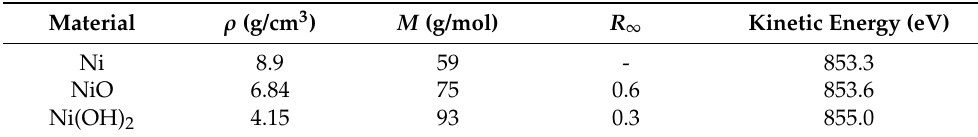
Figure 7. Spectra at different take-off angle of Fe 2p in NiFe(100 nm) thin film. Table 3. Relative peak intensities ( I s and I o ) and the I o / I s ratios for both iron oxides in the NiFe (100 nm) thin film. α (°)